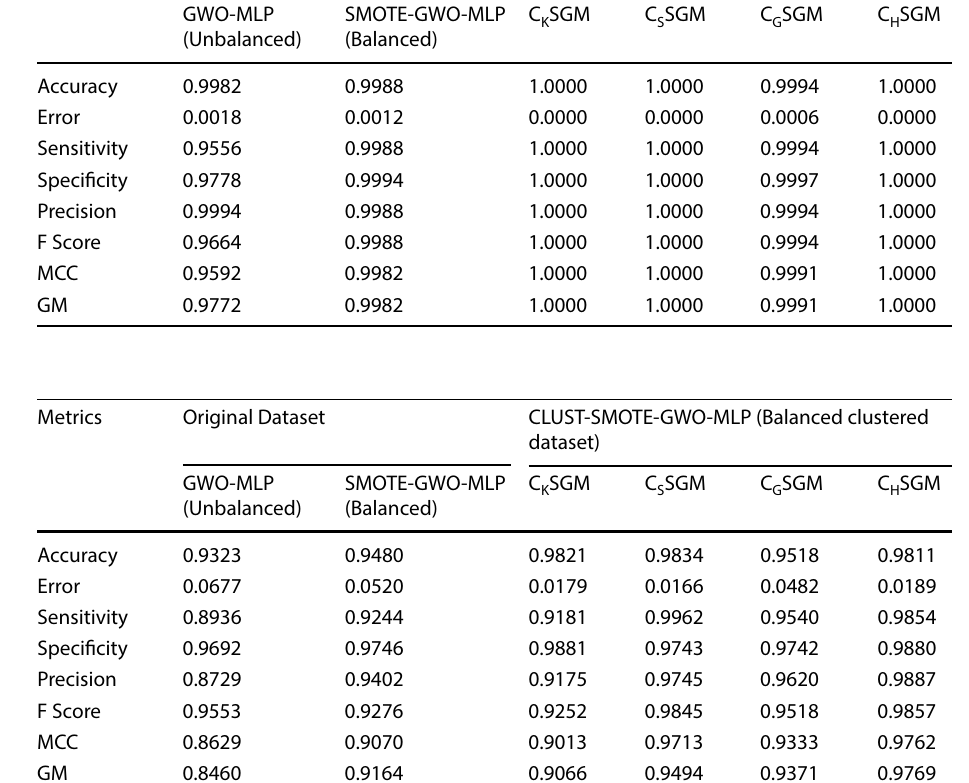
Table 11 Classification performance of GWO-MLP,